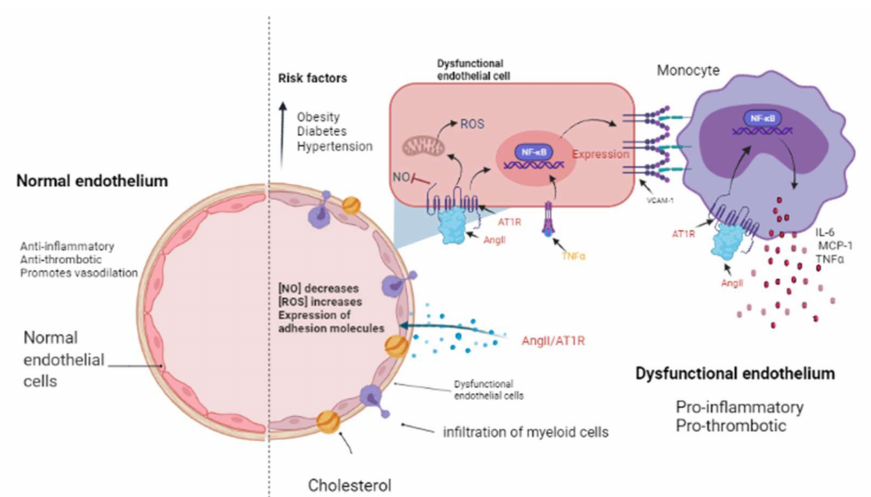
Figure 2. The endothelium in a normal and pathological state. The endothelium is a monolayer of cells that covers the interior of each major and minor vessel. A healthy endothelium has anti- inflammatory, anti-thrombotic properties and promotes vasodilation through nitric oxide (NO) release ( left side ). Cardiovascular risk factors such as obesity, diabetes and hypertension could promote a dysfunctional endothelium ( right side ) that is characterized by a decrease in NO release as well as an increment in reactive oxygen species (ROS) and a pro-inflammatory activity mediated by AngII/AT1R signaling, which activates NF- κ B and, consequently, the expression of cytokines, chemokines, and adhesion molecules: interleukin-6 (IL-6), monocyte chemoattractant protein-1 (MCP-1), and vascular cell adhesion molecule-1 (VCAM-1) by endothelial cells. Then, myeloid cells such as monocytes migrate and infiltrate towards the aortic walls (where they become macrophages) contributing to the endothelial dysfunction by producing tumor necrosis factor-alpha (TNF- α ), IL-6, and MCP-1. Image created with BioRender.com, Toronto, ON,